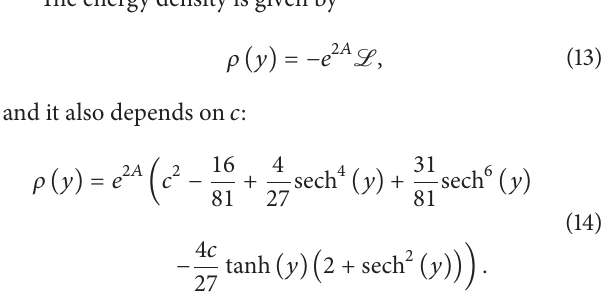
The energy density is given